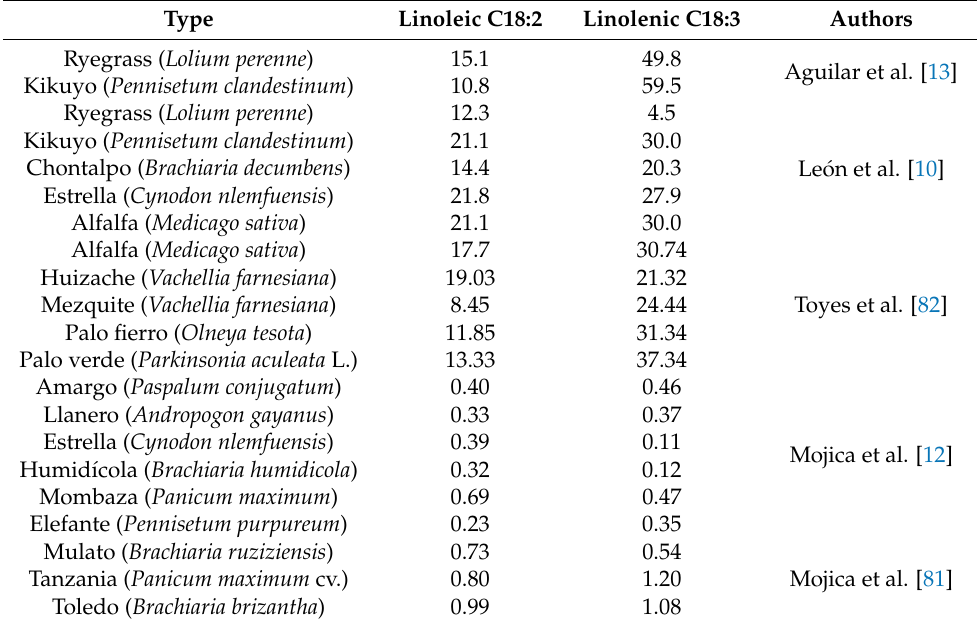
Table 4. Linoleic and α -linolenic acid (g/100 g of fat) contents in some grasses. Type